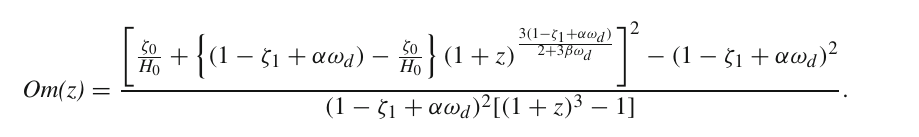
Fig. 8 a The r − s trajectories are plotted in r − s plane for different values of ζ 0 > 0 and ζ > 0 with ω = − 0 . 5, d 1 α = 0 . 8502 and β = 0 . 4817. The arrows represent the directions of the evolutions of statefinder diagnostic pair with time. b The r − q trajectories are plotted in r − q plane for different values of ζ 0 > 0 and ζ > 0 with ω = − 0 . 5, d 1 α = 0 . 8502 and β = 0 . 4817. The arrows represent the directions of the time evolution pair { r , q } with time